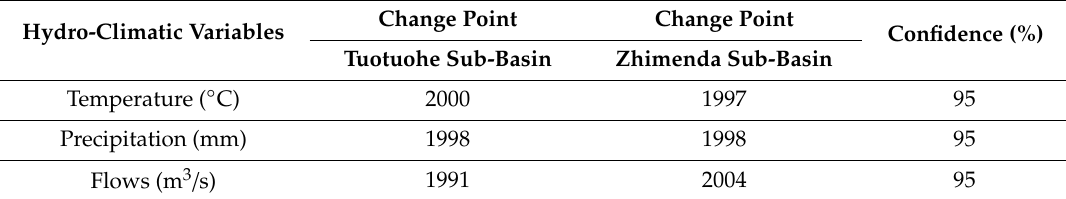
Table 5. Results and confidence levels of change point analysis from 1961–2015.